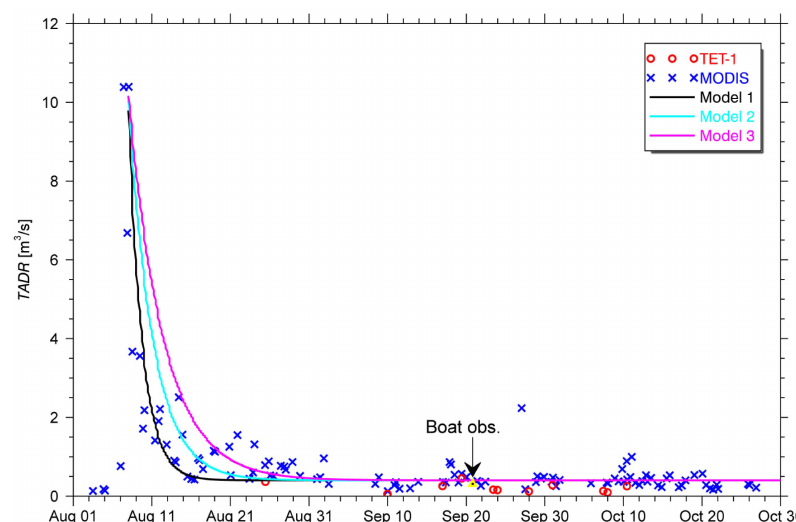
Figure 9. TADR in m 3 /s for observations along with the results of model calculations. The geometry of the model is shown in Figure 10 and the parameter varied is the length L (model 1 L = 20 m, model 2: L = 35 m, model 3, L = 50 m) of the tube feeding the flow at the vent. For more details on the model calculation, see Section 5.1.